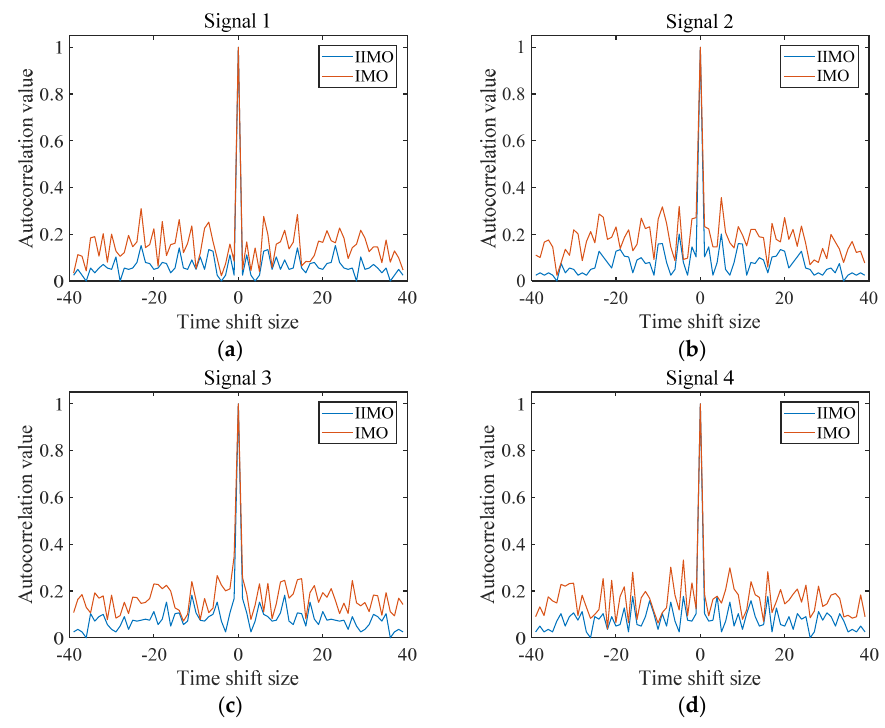
Figure 3. Autocorrelation values of polyphase codes obtained by IMO and IIMO under L = 4 and N = 40 on ( a ) signal 1, ( b ) signal 2, ( c ) signal 3 and ( d ) signal 4.